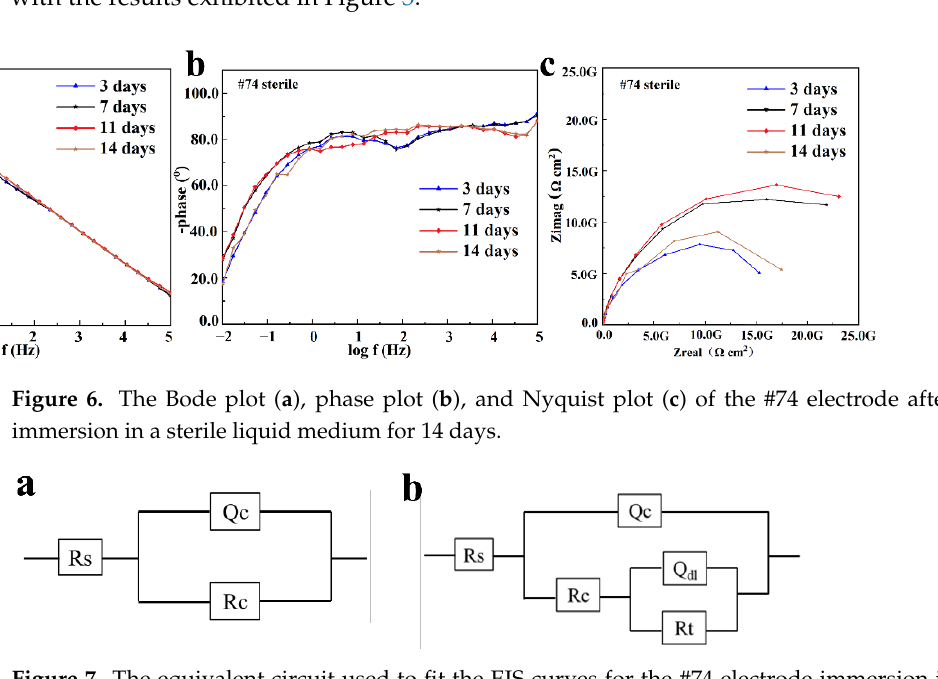
Figure 7. The equivalent circuit used to fit the EIS curves for the #74 electrode immersion in the sterile liquid medium and the #18 electrode immersion in the T. funiculosus -contained medium ( a ) and the #85 electrode immersion in the T. funiculosus -contained medium ( b ). Table 1. EIS fitting results of the #74 electrode immersion in the sterile liquid medium for different times.